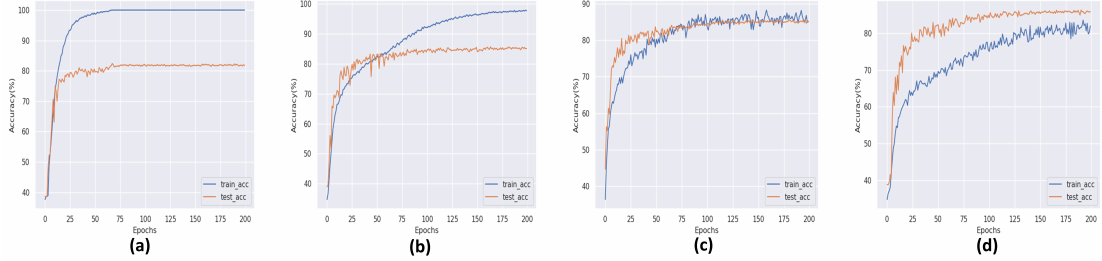
Figure 5. Performance of eXnet on the RAF-DB.